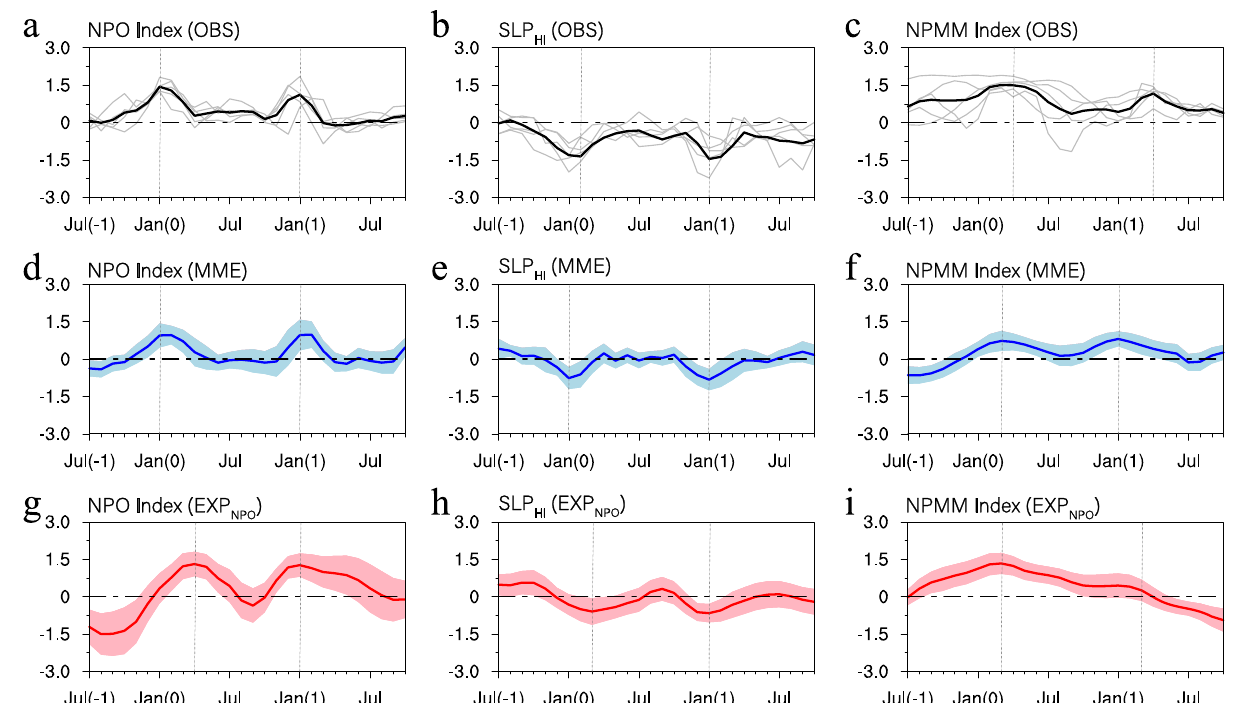
Fig. 3 Temporal evolutions of various indices over the North Paci fi c for multi-year El Niño events. a – c Temporal evolutions of the NPO index, the SLP index over the Hawaiian region (SLP HI ), and the NPMM index from July( − 1) to October(1) for the observed multi-year El Niño events, respectively. d – f As in a – c , but for multi-year El Niño events in the CMIP5/6 models. g – i Ensemble-mean difference in the NPO, SLP HI , and NPMM indices from July( − 1) to October(1) between the positive NPO forcing and CTRL experiments. In a – c , the gray curves indicate individual evolutions of the observed multi-year El Niño events, and the black curve indicates the mean of the gray curves. In d – i , the colored shading indicates interquartile ranges between the 25th and 75th percentiles. In a – i , the vertical dashed lines denote the time when various indices reach the peak.